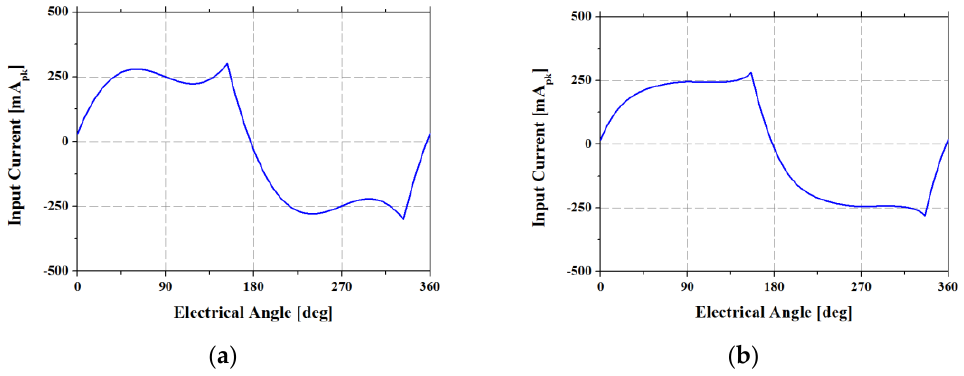
Figure 17. Comparison of the input current waveforms of the base and proposed models: ( a ) base model; ( b ) proposed model.